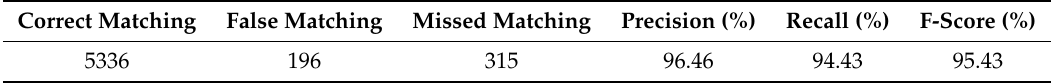
Table 5. Stereo taillight matching